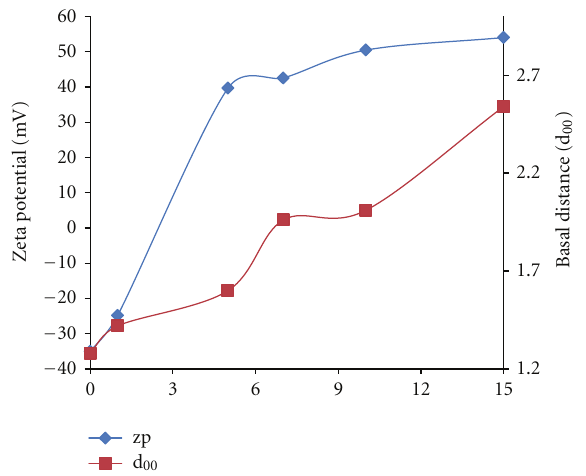
Figure 1: The change of interlayer distance and zeta potential values at various CTAB/clay ratios.